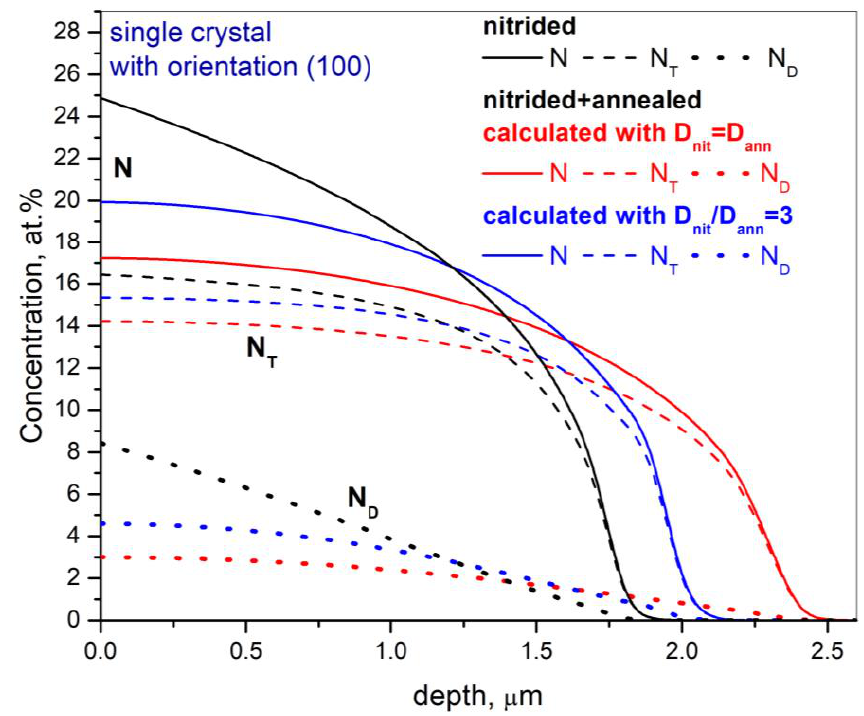
Figure 3. Calculated (with different D nit /D ann ratios) depth profiles of nitrogen in the (100)-oriented single crystal of ASS after nitriding (for 60 min at 400 °C) and after isothermal annealing (for 30 min at 400 °C). N D — nitrogen in normal lattice, N T — nitrogen at trap sites, and N — total nitrogen concentration.